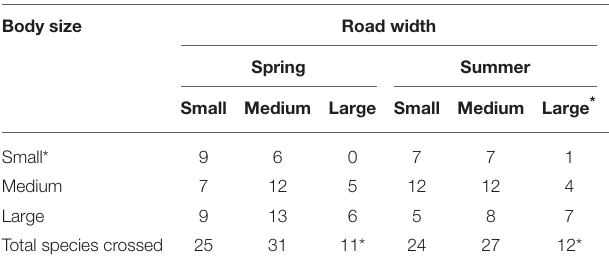
TABLE 4 | Total species observed to cross roads arranged by body